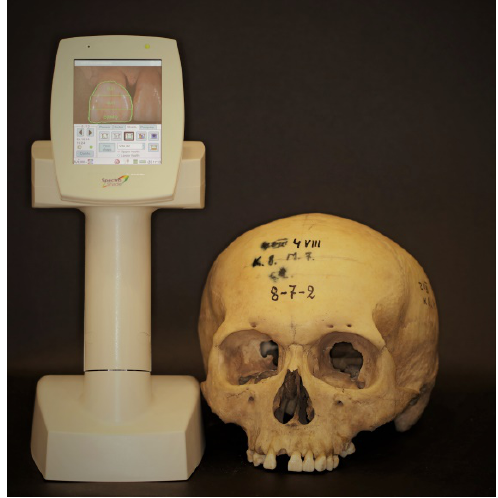
Figure 3. Studied sample spectrophotometric colour